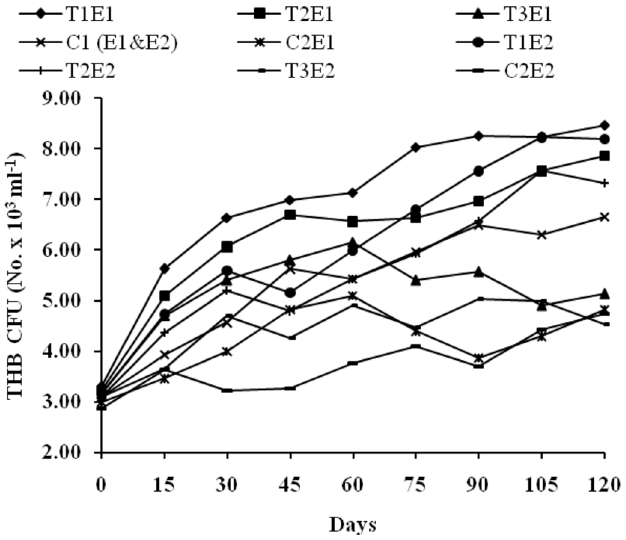
Fig. 8. Temporal changes of THB in soil in the treatments of E1 and E2.